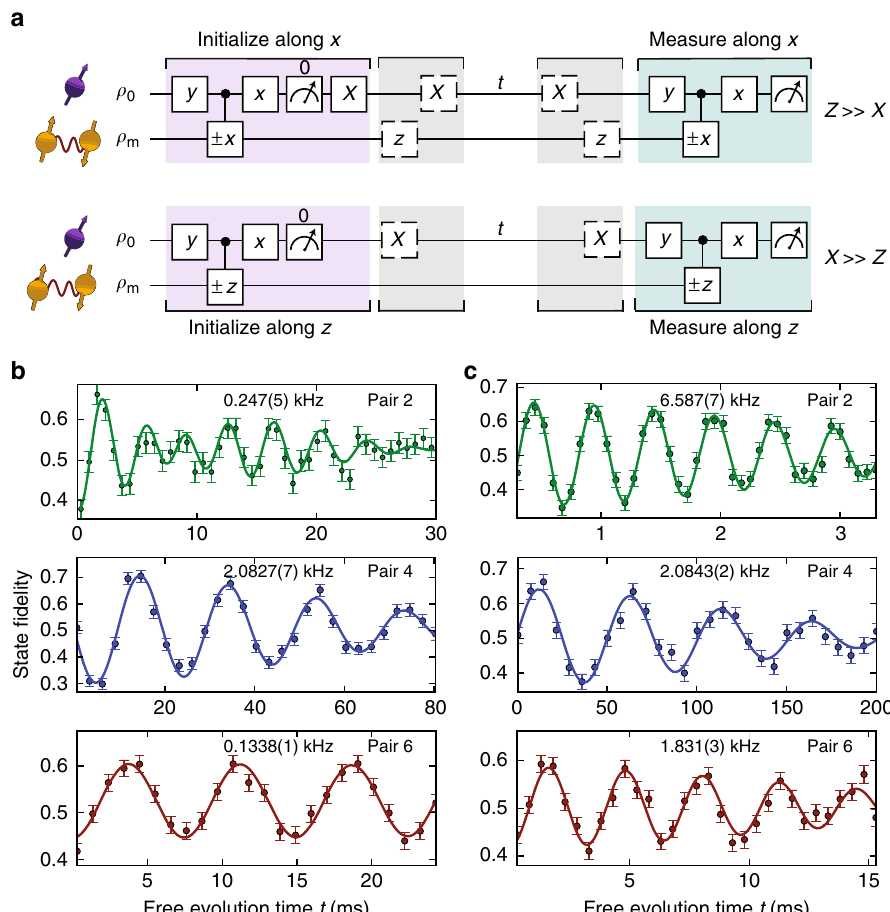
Fig. 3 Direct spectroscopy of nuclear-spin pairs. a Measurement sequences for Ramsey spectroscopy of 13 C – 13 C pairs, for Z >> X and for X >> Z . The controlled ± x (± z ) gates are controlled ± π /2 rotations around x ( z ) with the sign controlled by the electron. The initial states are ρ state ρ m . b , c Nuclear spin Ramsey measurements and obtained precession frequencies for pairs 2, 4, and 6. The electron spin state during the free evolution time t is set to m s = 0 ( b ) or m s ¼ (cid:2) 1 ( c ) and an arti fi cial detuning is applied. Each pair yields a unique set of frequencies, con fi rming that the pairs are distinct. For pair 2 an additional beating is observed (frequency of 23(3) Hz), indicating a small coupling to one (or more) additional spins. See Supplementary Fig. 3 for the other three pairs and Supplementary Table 4 for fi t results. All error bars are one statistical